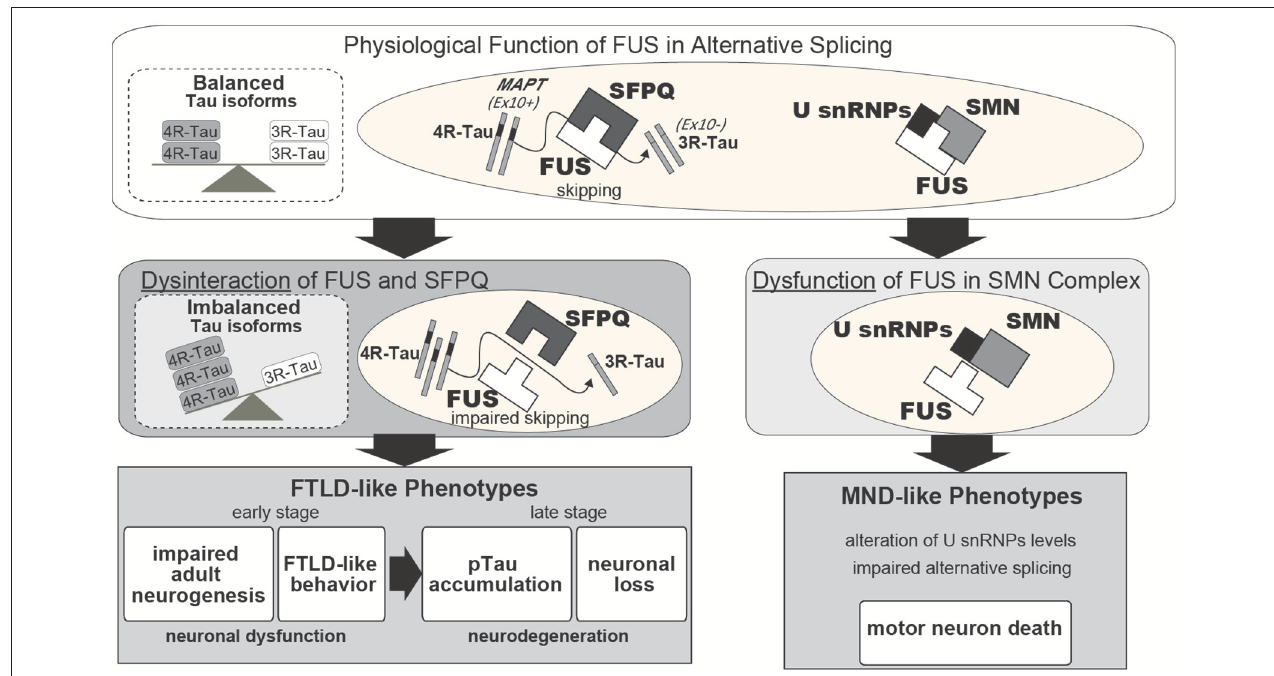
FIGURE 1 | Proposed pathway underlying neurodegeneration following a qualitative loss of function of FUS in alternative splicing. Under normal neuronal physiological conditions, FUS and SFPQ interact in the nucleus to regulate alternative splicing of MAPT by skipping exon 10. When this functional machinery is impaired, such as occurs following FUS or SFPQ depletion, or qualitative loss due to disease-associated mutations or other unknown aberrant modifications, the splicing ratio of MAPT exon 10 + /exon 10- is increased, which in turn results in an increased 4R-Tau/3R-Tau ratio. The quantitative or qualitative loss of FUS or SFPQ causes various phenotypes, including reduced neurite outgrowth, aberrant adult neurogenesis, FTLD-like behavioral impairments, hippocampal atrophy with neuronal loss, and phosphorylated Tau accumulation. Normalization of imbalanced Tau isoforms by co-injection with shRNA against 4R-Tau can successfully rescue these phenotypes. Thus, our findings suggest that a pathophysiological link between FUS/SFPQ and the regulation of 4R-Tau/3R-Tau isoforms is involved in the pathogenesis of FTLD and 4R-tauopathy. FUS also binds to the U-rich small nuclear ribonucleoproteins (U snRNPs) and SMN complexes in the spliceosome with disease-associated mutations in FUS affecting this alternative splicing